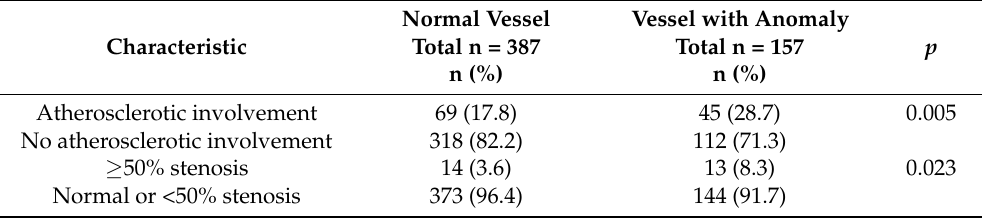
Table 5. Comparison of normal and anomalous vessels in terms of atherosclerotic involvement. Vessel with Anomaly Normal Vessel p Total n = 157 Characteristic Total n = 387 n (%) n (%) Atherosclerotic involvement 69 (17.8) 45 (28.7) 0.005 No atherosclerotic involvement 318